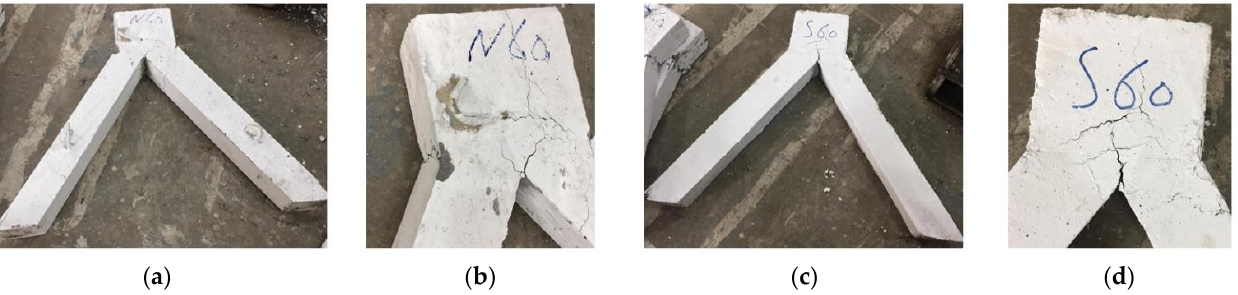
Figure 11. V-shaped columns with 90° angle ( a ) NRC-90, ( b ) NRC-90 failure zone, ( c ) FRC-90, and ( d ) FRC-90 failure zone. On the other hand, no cracks occurred at the legends during the test for the other V- shaped columns. It was noted that all the V-shaped specimens showed exposure concrete crushing of the compression face at the ultimate load, excepting NRC-90 specimens, as shown in Figures 10 and 11. The V-shape columns sustained the load, even though the crack width increased as the degree of angle increased compared to NRC columns. Along with these significant cracks in the FRC, many fine cracks began due to the crack-bridging effect of MSSF. The MSSF considerably decreased the crack width of the FRC-30, FRC-60, and FRC-90 columns by 23, 22, and 20% compared to the NRC-30, NRC-60, and NRC-90 columns, respectively. The variation in the volume of fine cracking was affected by the tensile strength, which is impacted by the bridging effect of fiber crack.